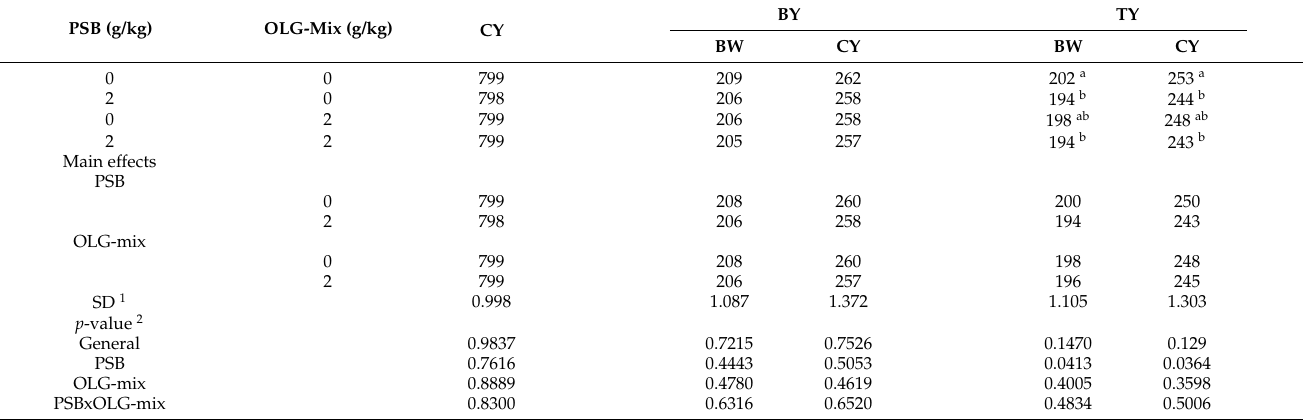
Table 4. Effect of protected sodium butyrate (PSB) olive leaf and grape-based by-product (OLG-mix), and their interaction on carcass yield (CY), breast yield (BY) and thigh yield (TY), expressed by g/kg of body weight (BW) and g/kg of CY at slaughter (40 days of